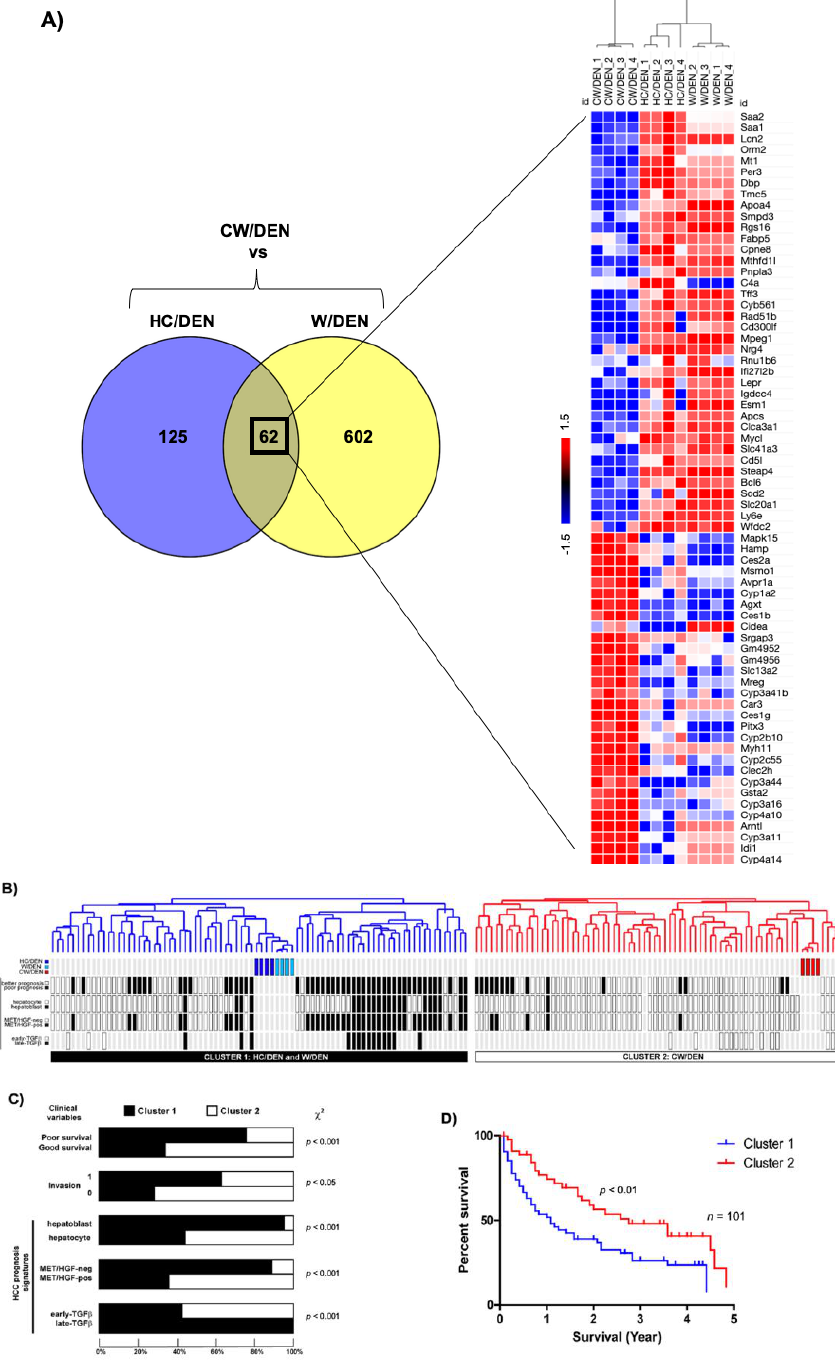
Figure 5. Cholesterol-enriched diet consumption promotes liver tumors. ( A ) Venn diagram differentially depicting expressed common genes between HC/DEN and W/DEN groups ( n = 4). Heatmap shows the common 62 genes indicating the fold change value. ( B ) Dendrogram overview of mice tumors integrated with 101 cases of human HCC. Clustering analysis was based on the expression of 62 ortholog genes in W/DEN and HC/DEN. Two clusters (1 and 2) were identified. ( C ) Distribution of human HCC samples between previously described subgroups with respect to survival (better vs. poor prognosis), cell origin (hepatoblast vs. hepatocytes), activation of MET/HGF), and TGF- β -signaling pathway (early vs. late) is indicated on the left. F, statistical analysis of HCC distribution between clusters 1 and 2 based on previous gene signatures and clinical parameters. Cluster 1, which is defined by the W/DEN and HC/DEN signature, shows a significant enrichment in HCCs with the following features: bad survival, hepatoblast traits, activation of MET/HGF, and late TGF- β pathways. ( D ) Kaplan–Meier plots and log-rank statistics analysis revealed a significant decrease in overall survival for patients included in cluster